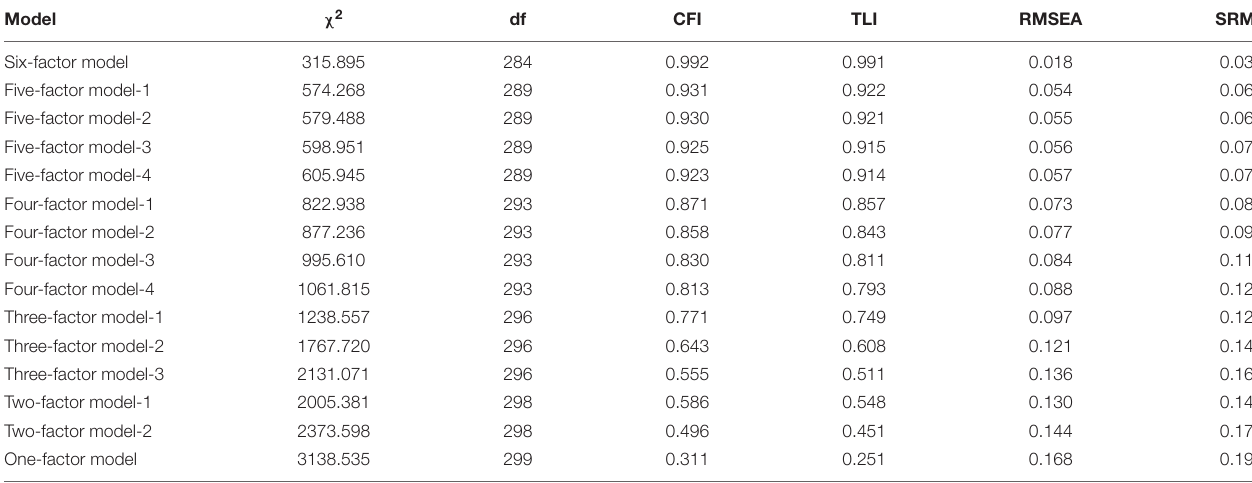
TABLE 1 | Results of confirmatory factor analysis.